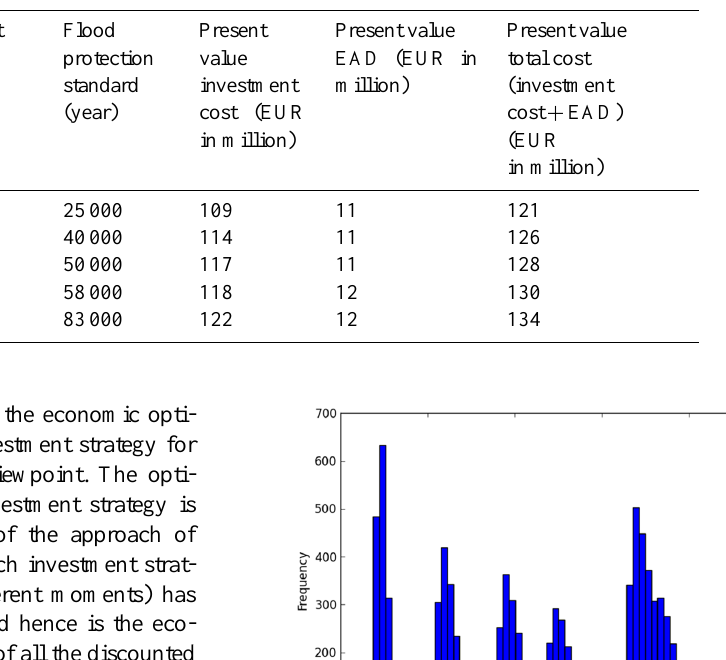
Figure 5. Map of the case study area. The green line is the dike segment under investigation; the cross indicates the location of the breach scenario which was used. Table 3. Optimal investment strategy given different damage estimates. The flood protection standard is a return period based on the direct method described in Kind (2011), note that the actual return period of the investment strategy differs per year. Price level 2011 is used.